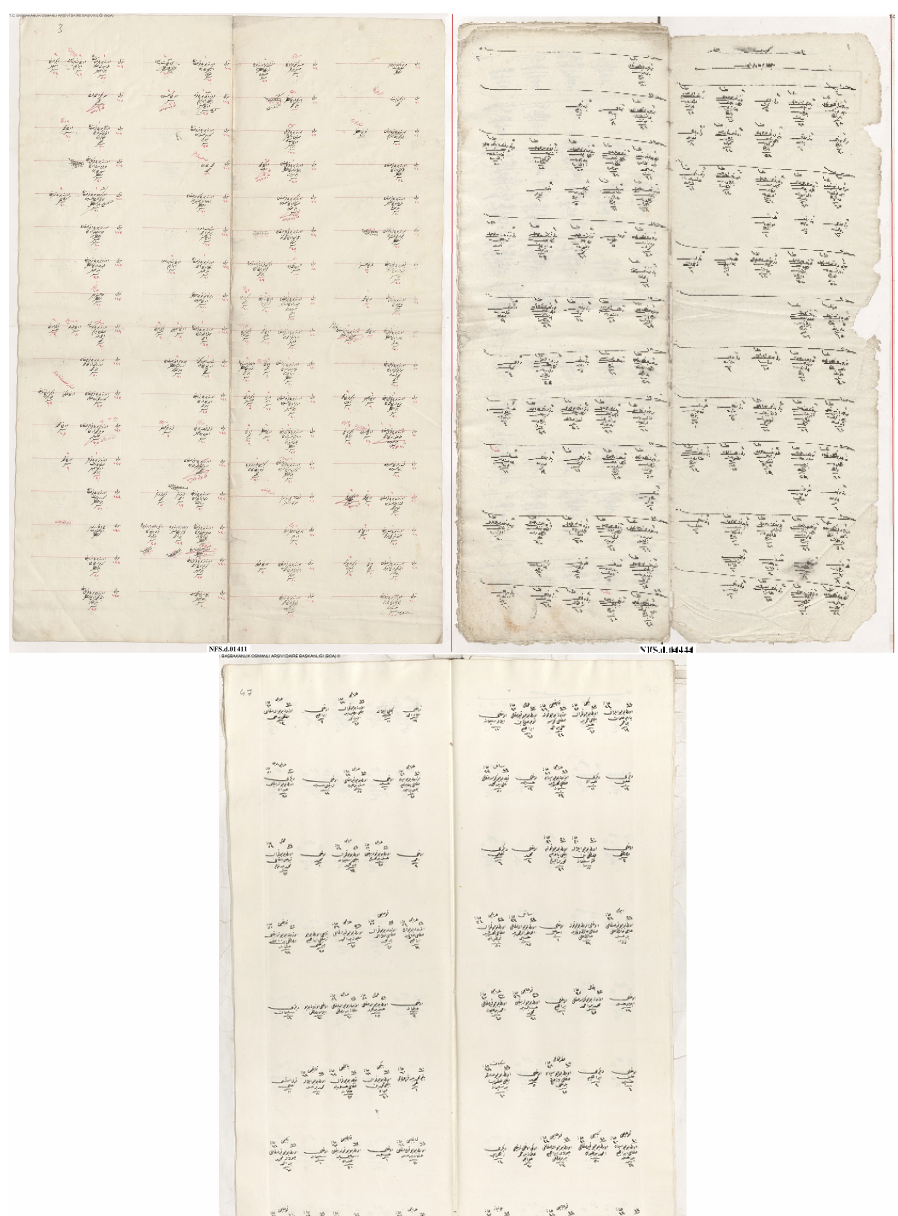
Figure 1. Three sample pages of the registers belonging to three different districts. The layout of pages can change between